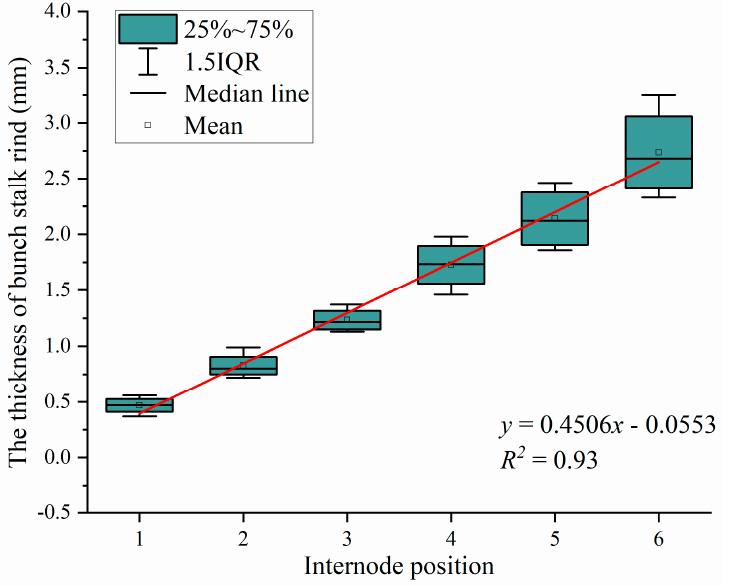
Figure 7. The relationship between the thickness of bunch stalk rind and the internode positions.